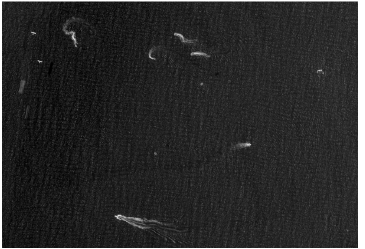
Figure 9. SAR image of sea surface